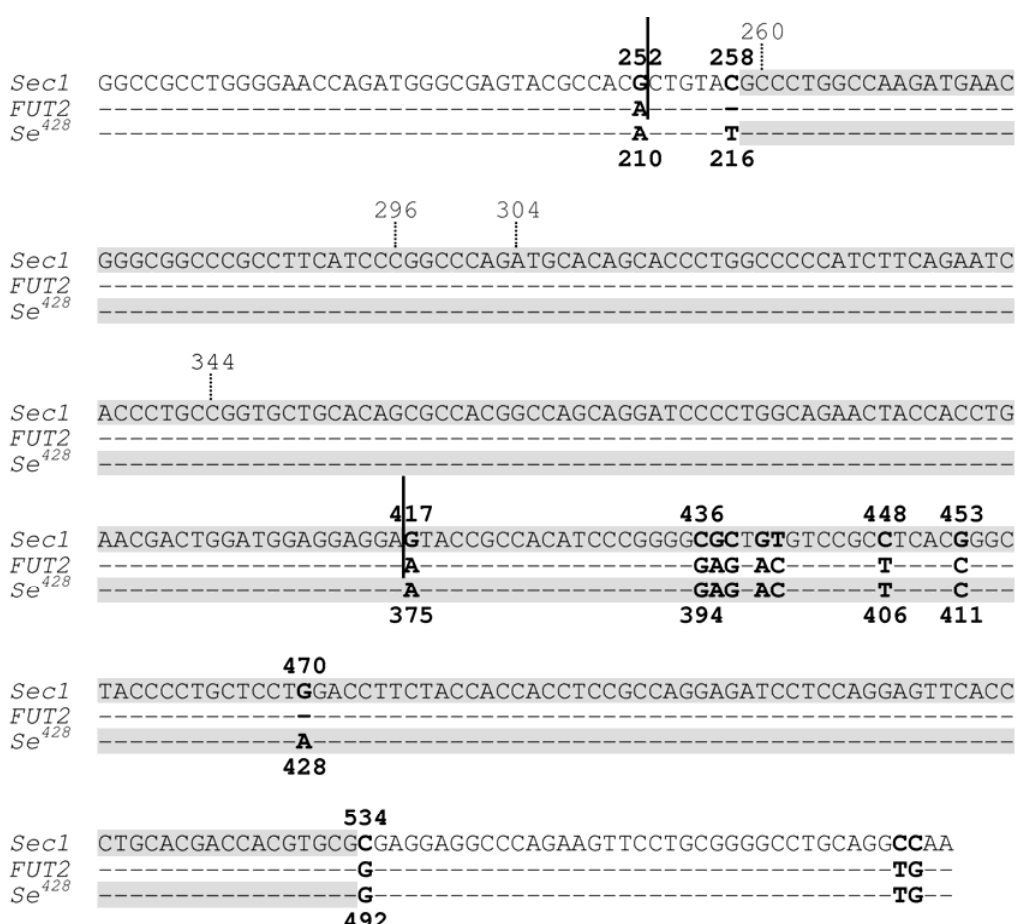
Figure 2. Partial sequence alignment of the Sec1 gene, the FUT2 gene and the Se 428 mutant allele of the FUT2 gene. Dashes indicate identity with Sec1 DNA sequence. Nucleotides are numbered in accordance with previous publications (e.g., [11]) for easy comparison; numbers above the aligned sequences refer to Sec1 sequence whereas those below the aligned sequences refer to both FUT2 and Se 428 sequences. As compared with the wild-type FUT2 gene, the Se 428 mutant allele contains the 428G > A nonsense mutation and the 216C > T polymorphism. Sequence between the two vertical continued bars indicates the crossover region of the non-allelic homologous recombination-derived Se fus allele, in which the 3'-part of the FUT2 gene was fused to the 5'-part of the Sec1 gene. Shaded sequences indicated the maximal converted tract (MaxCT) of the gene conversion-derived Sec1 - Se 428 - Sec1 allele ( Sec1 is the acceptor gene whilst Se 428 is the donor gene). The overlapping sequence tract between the MaxCT of the Sec1 - Se 428 - Sec1 allele and the crossover region of the Se fus allele spans positions 259 to 416 in the context of the Sec1 sequence. Reprinted from